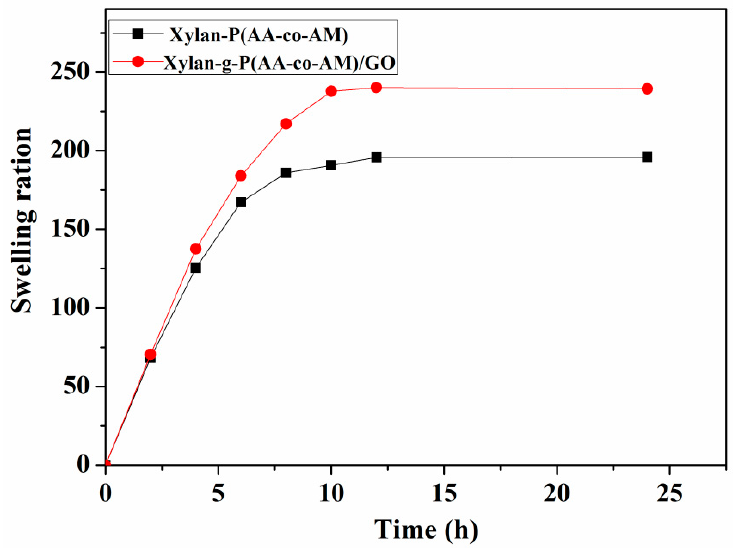
Figure 4. Equilibrium curve of hydrogel swelling in deionized water.